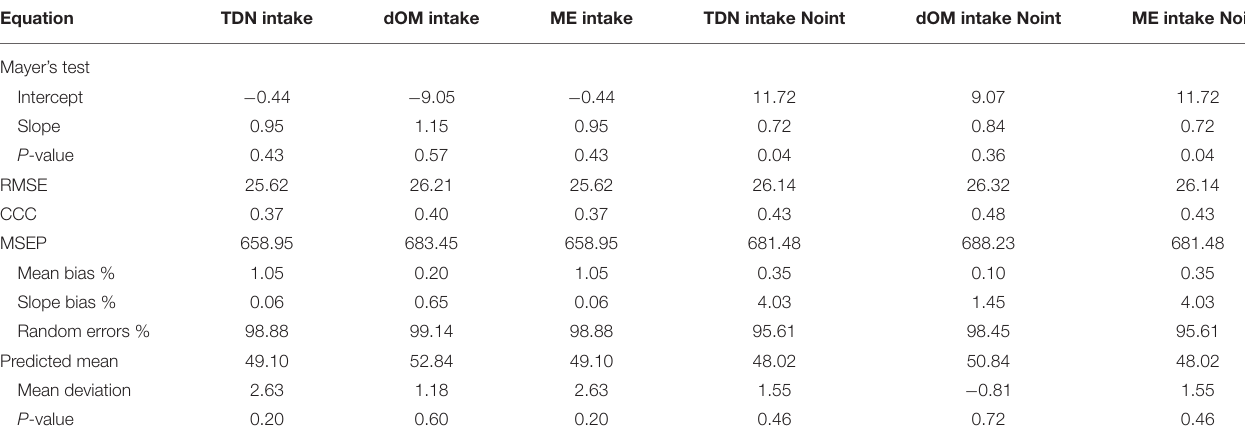
TABLE 3 | General evaluation of the proposed models, with or without intercept (Noint), to estimate microbial crude protein efficiency in sheep and goat species from energy intake measurements. Equation TDN intake dOM intake ME intake TDN intake